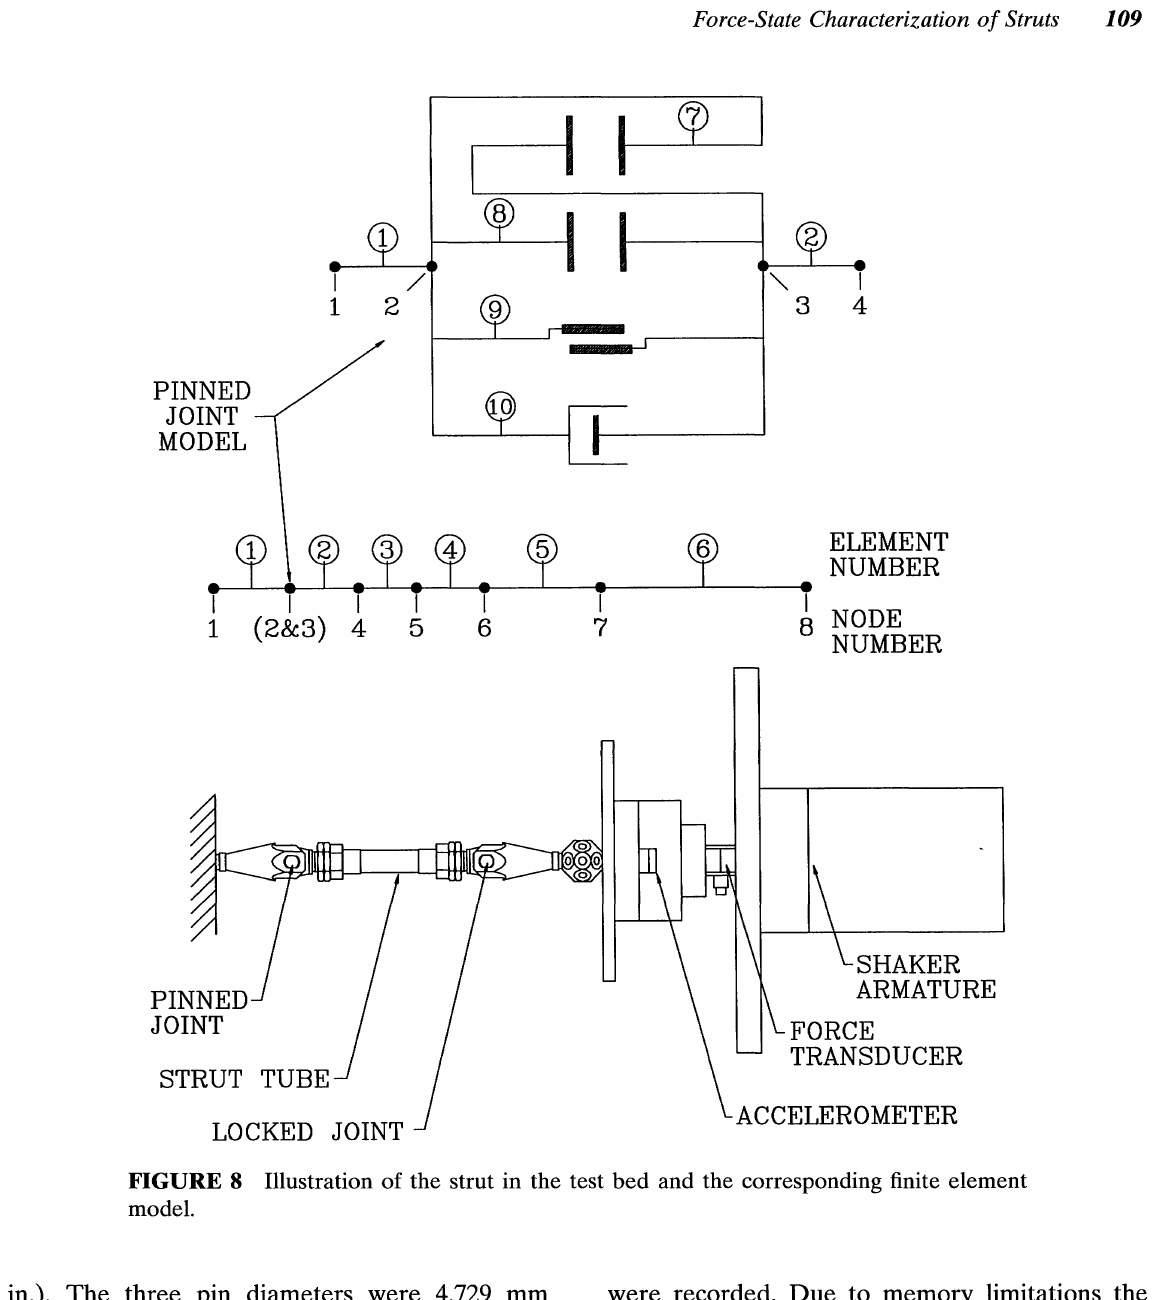
FIGURE 8 Illustration of the strut in the test bed and the corresponding finite element